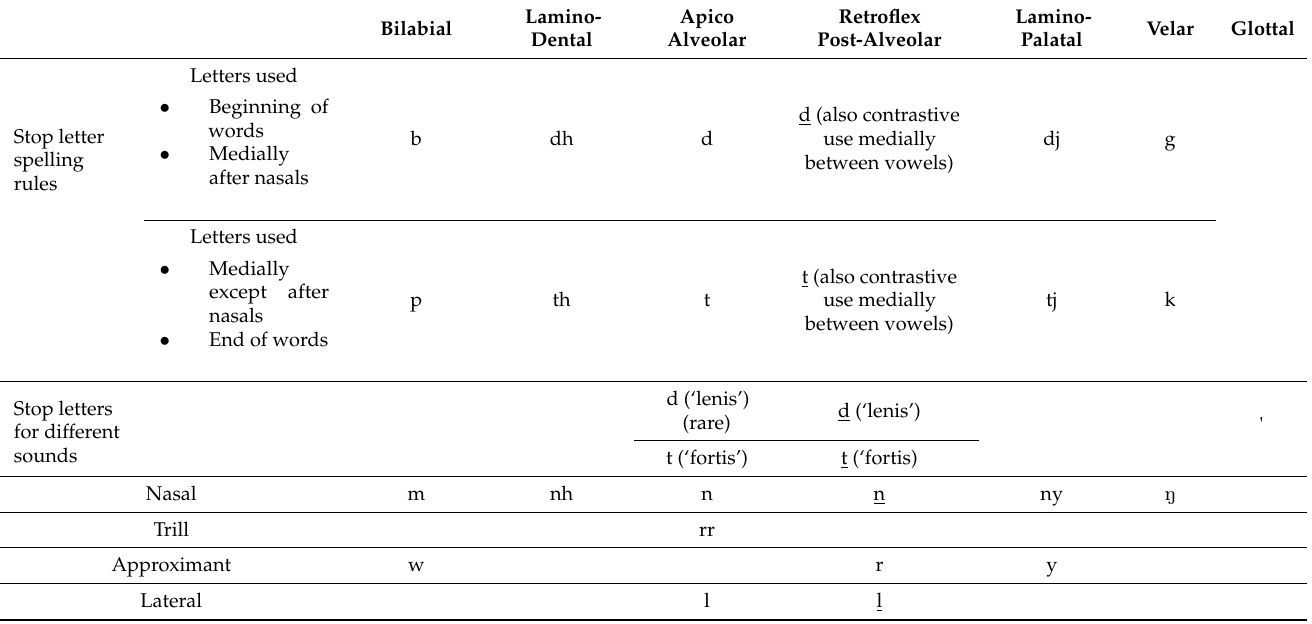
Table 1. Orthographic consonant representations.